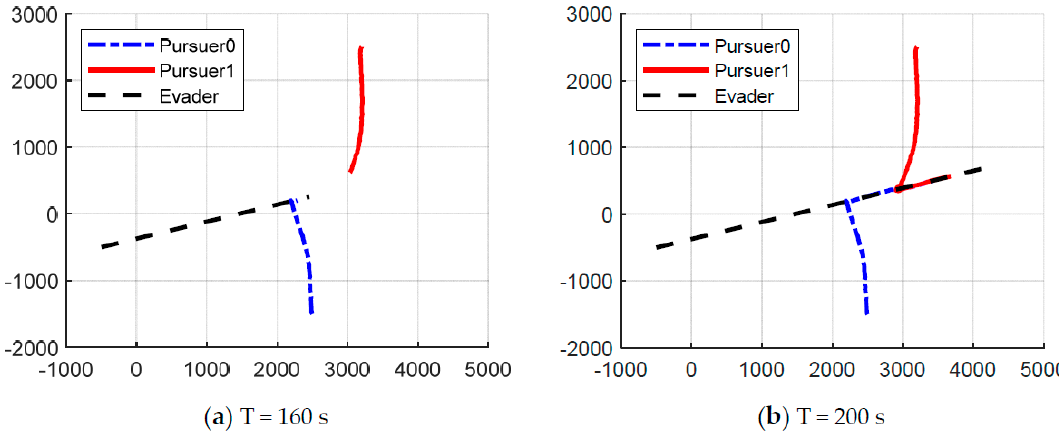
Figure 13. The traces of P 0 , P 1 and E 0 under the FACL with ∆ v = 30% v P .